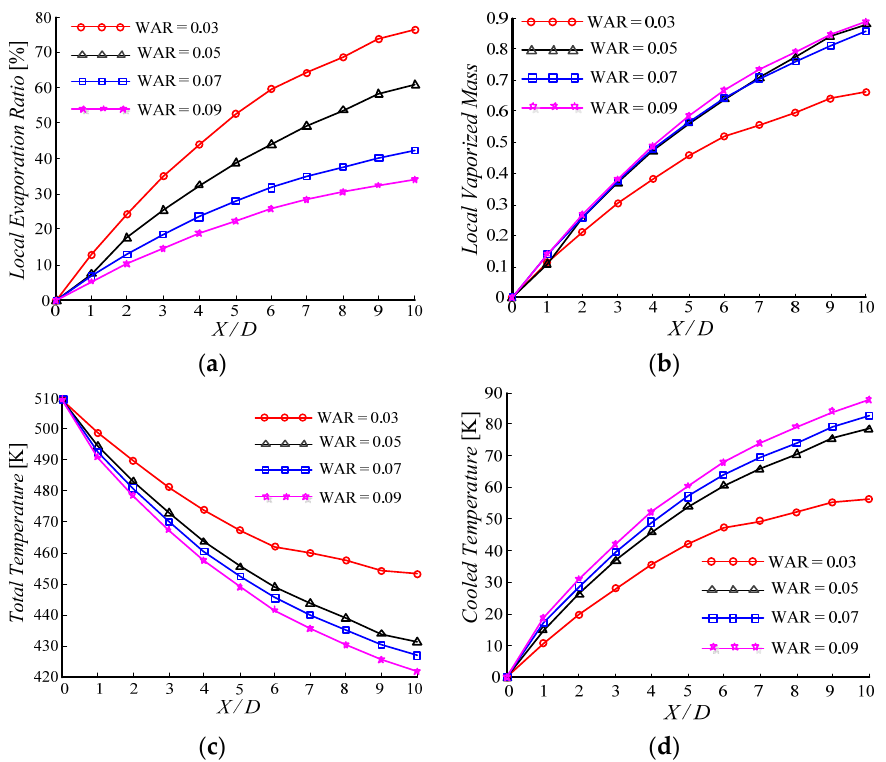
Figure 13. The evaporation and temperature along the inlet ( a ) local evaporation ratio, ( b ) local vaporized mass, ( c ) total temperature, ( d ) cooled total temperature.